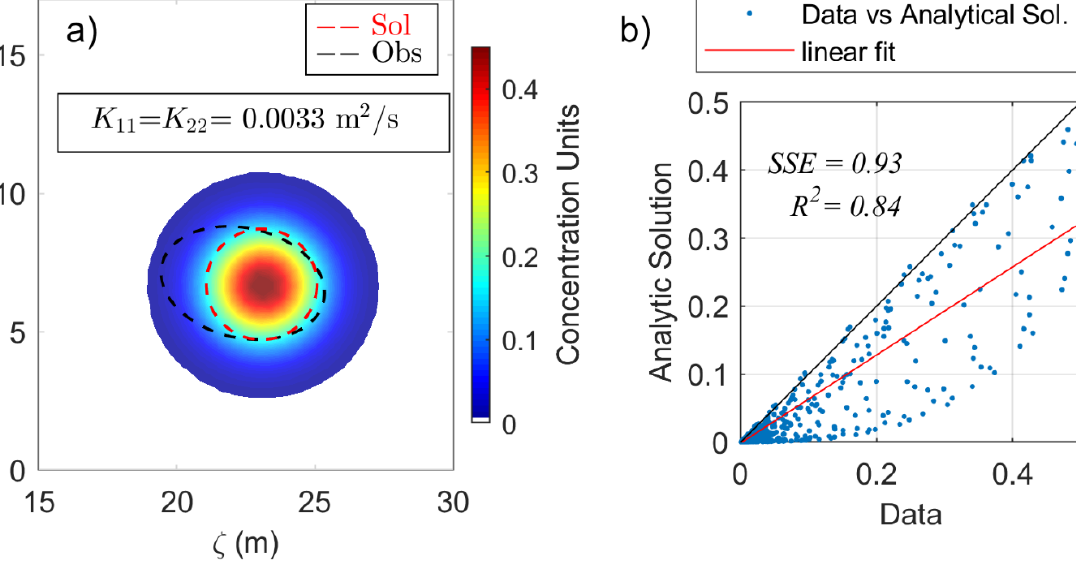
Figure 9. ( a ) Concentration contours obtained with optimal diffusion coefficients for 𝐾 11 ≠ 𝐾 22 . Observations are shown in black and the solution in red. In ( b ), the dispersion diagram of the data and the analytical solution with SSE and 𝑅 2 is shown. Additionally, in Figure 10a, when 𝐾 11 ≠ 𝐾 22 and 𝐾 12 = 𝐾 21 ≠ 0 , a major improve- ment was achieved as the solution had an ellipse shape, and the orientation matched with the observations; however, a slight shift to the right was still presented.